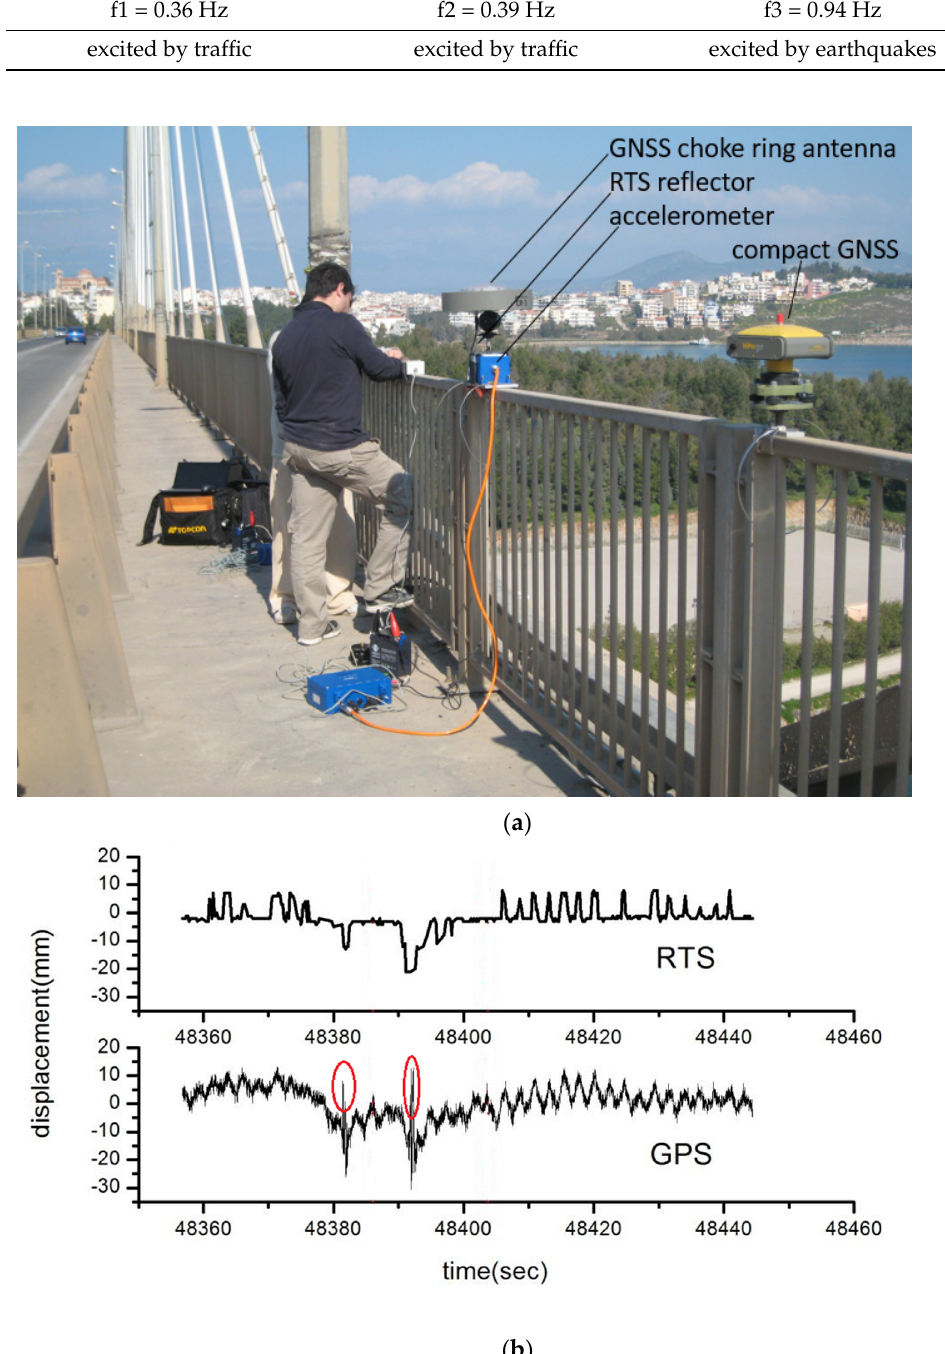
Figure 2. ( a ): Multi-sensor monitoring at the midspan of the Evripos Bridge, Greece. The disk-type GNSS antenna is of choke-ring type, to minimize multipath. ( b ): Vertical, long-period deflections produced by two passing trucks were recorded by RTS and GNSS. The GNSS record is clear and broadly consistent with that of RTS, although it is contaminated by two high-frequency peaks (in ellipses) reflecting dynamic multipath. This high-frequency noise can be easily removed with low-pass filtering of long-period deflection records. For more details see [17]. Table 2. Characteristic modal frequencies of the Evripos suspension Bridge, Greece. Based on [24].